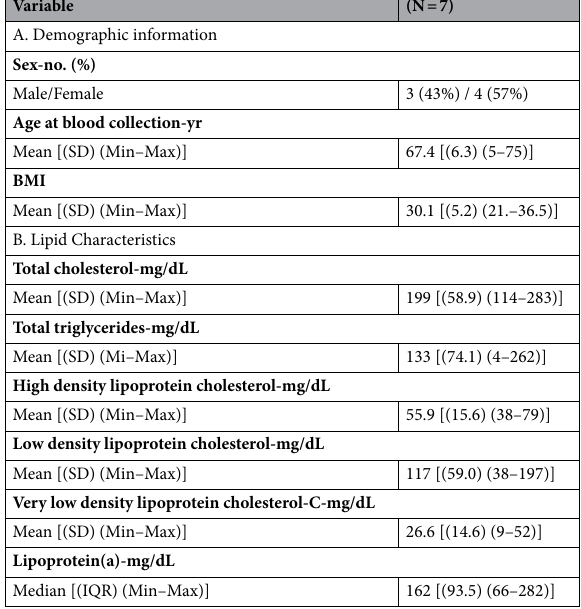
Table 1. Patient Characteristics and Lipid Profiles.